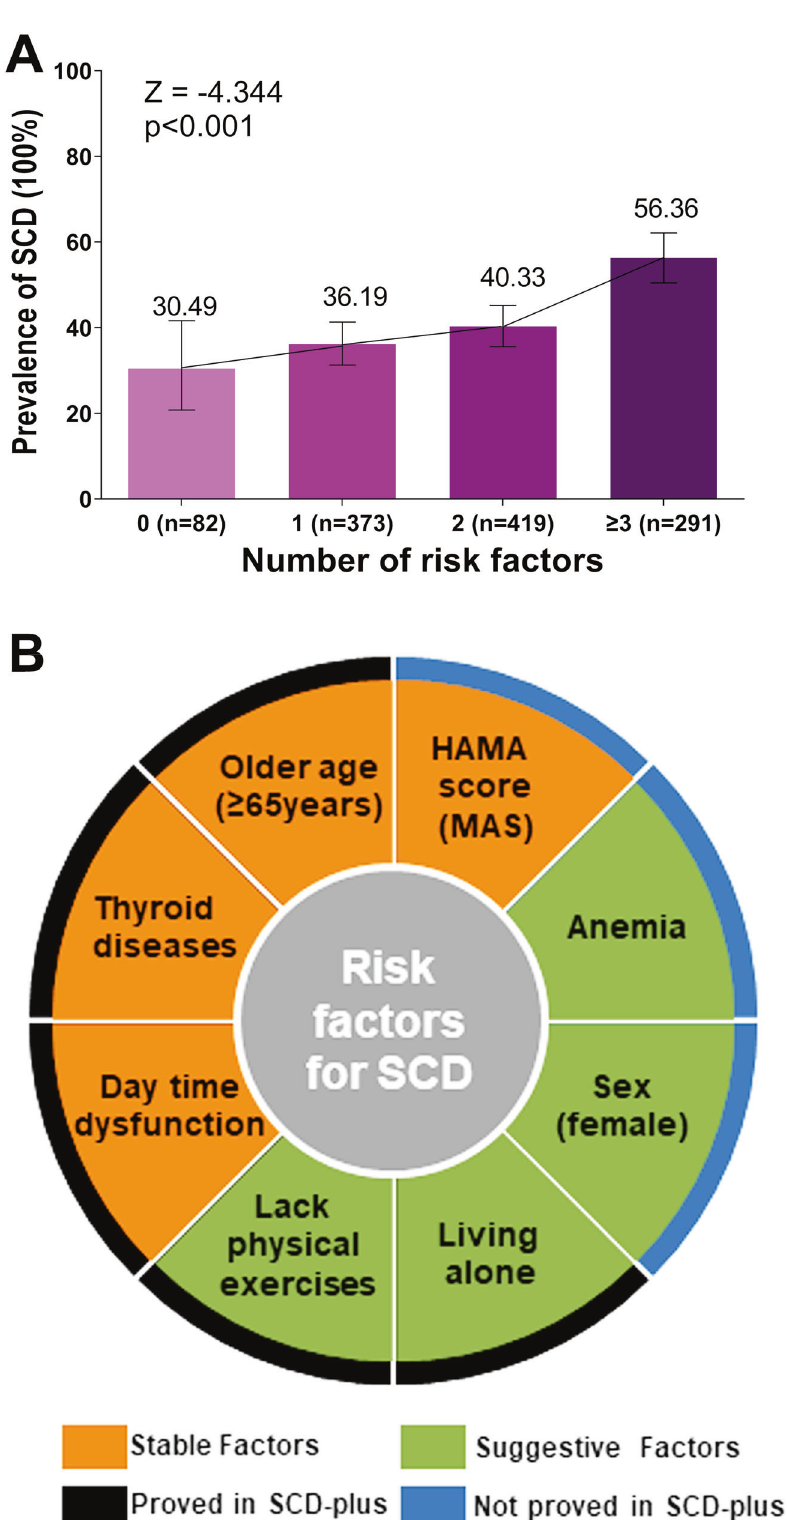
Fig. 3 Trend test and the summary of risk factors. A The Cochran-Armitage trend test was used to con fi rm the constant trend toward higher prevalence of SCD with an increasing number of risk factors. B A summary chart of risk factors was established. A total of eight factors were found associated with SCD including four stable factors proved by two multivariate models and four suggestive factors proved by one of the two multivariate models. Five of the above eight factors were veri fi ed as risk factors for SCD-plus. Abbreviations: SCD: subjective cognitive decline; HAMD: Hamilton depression scale; MDS: minimal depression